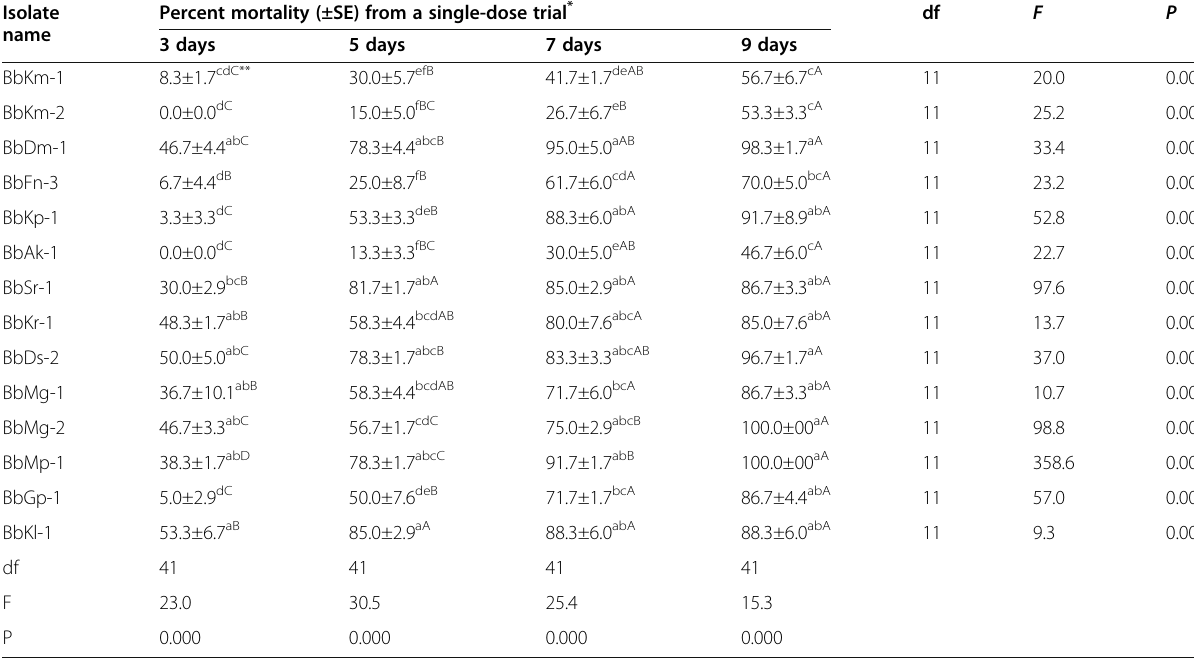
Table 3 Percentage mortalities of young larvae (1st and 2nd instars) of Leptinotarsa decemlineata in response to the tested Beauveria bassiana isolates at 3, 5, 7, and 9 days after treatment under laboratory conditions Isolate